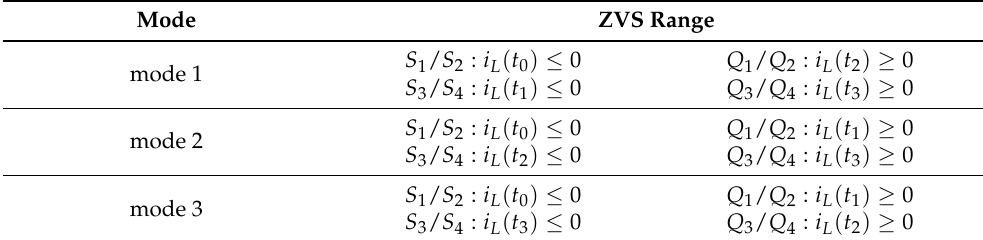
Table 2. ZVS range of modes 1–3 of TPS